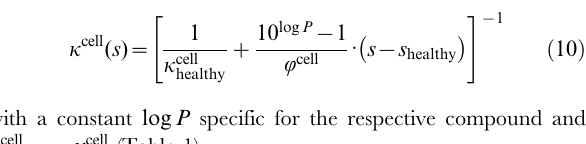
Figure 4. In this setting, s ( x ) ~ s healthy ~ 0 : 04485 corresponds to the healthy state